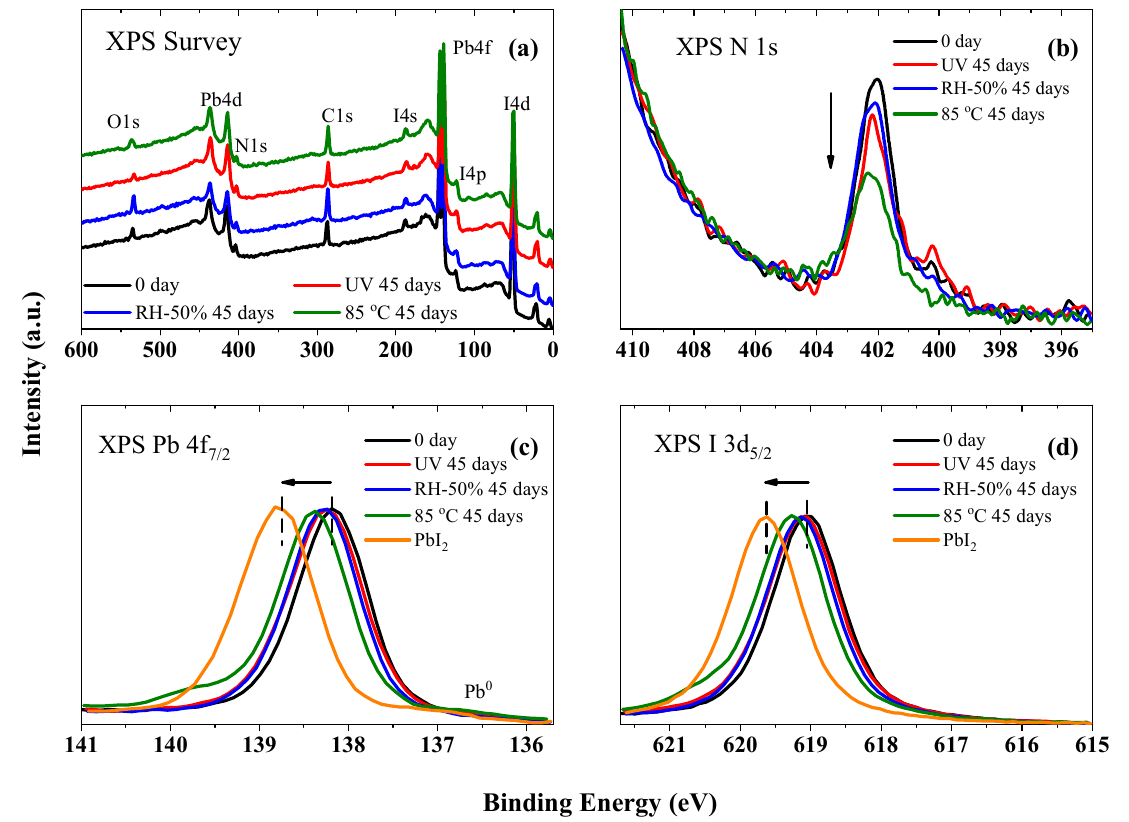
Figure 8. ( a ) XPS survey and ( b ) N 1s, ( c ) Pb 4f 7/2 , and ( d ) I 3d 5/2 spectra of the pristine sample before and after light soaking, heat stress, and relative humidity treatment for 45 days.